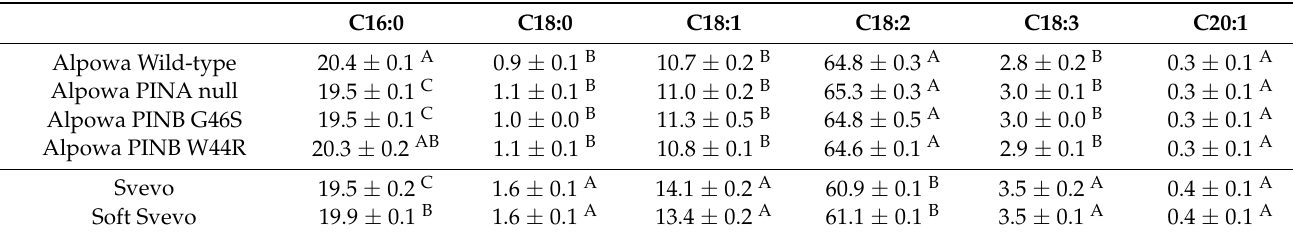
Table 3. Fatty acid composition (% of total fatty acids) of flours from near-isogenic wheat